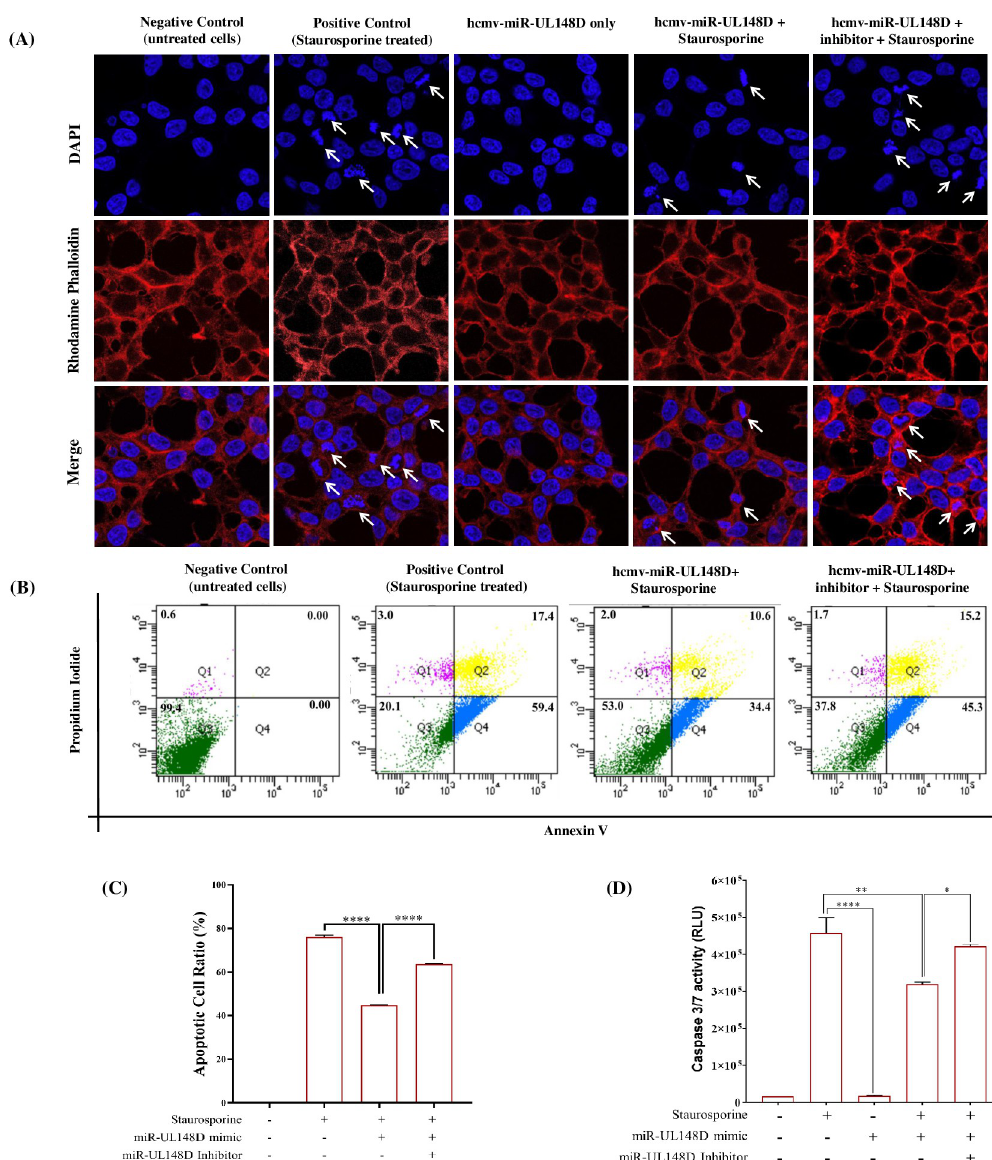
Fig 2. Antiapoptotic effects of hcmv-miR-UL148D in staurosporine-treated HEK293T cells: (A) hcmv-miR-UL148D mimic or inhibitor transfected HEK293T cells were treated with staurosporine followed by counterstaining with the DAPI and rhodamine phalloidin. The arrow indicates the significant changes associated with the apoptosis as decrease in the chromatin condensation and nuclear fragmentation by hcmv-miR-UL148D (image acquired at 63X). (B) From the same set of groups as in Fig A, cells were stained with propidium iodide and annexin V followed by flow cytometry analysis. The flow cytometry data represented in dot plots show decrement of apoptotic cells by hcmv-miR-UL148D. (C) The apoptotic cell ratio was calculated from the flow cytometric data using ImageJ (mean ± SEM; ���� , p < 0.0001). (D) HEK293T cells were transfected with hcmv-miR-UL148D mimic or inhibitor then treated with staurosporine. Caspase 3/7 activity was measured from cell lysate using luminescence and expressed as raw luminescence units (RLU). Results represent the mean ± SEM (n = 3 independent experiments) �� p < 0.01; ��� p < 0.001; ���� p < 0.0001. 0.22 × 10 5 , which is less when compared to the RLU obtained through the cell group treated with staurosporine ( Fig 2D) . These results strengthen the argument that the hcmv-miR- UL148D is directly linked to apoptosis regulation in staurosporine treated HRK293T cells.